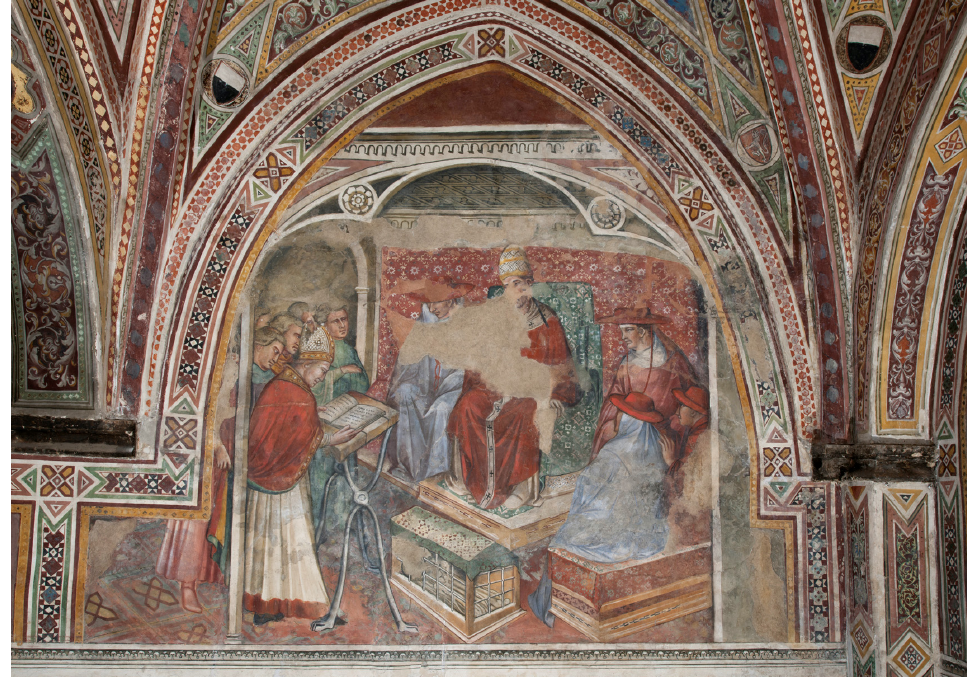
Figure 5. Spinello Aretino, Reading of the Miracles of Thomas Becket for his Canonization , 1407–1408, frescoe, Sala della Balìa, Palazzo Pubblico, Siena (photo: Fabio Lensini, © Comune di Siena).